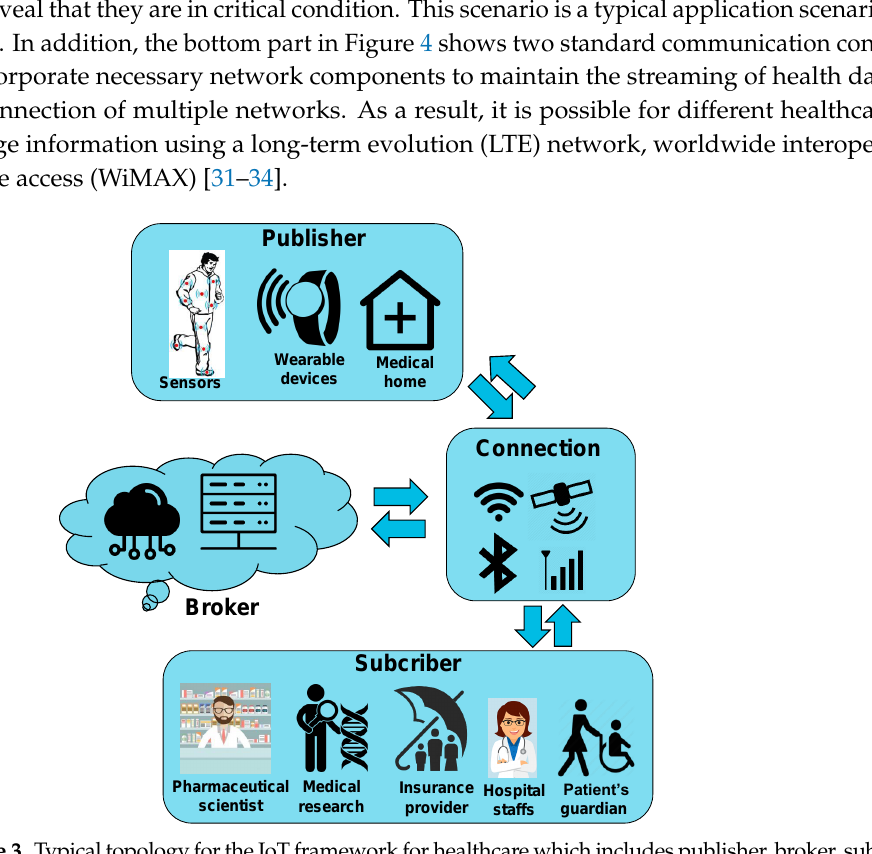
Figure 3. Typical topology for the IoT framework for healthcare which includes publisher, broker, subscriber and the connection technologies between them.